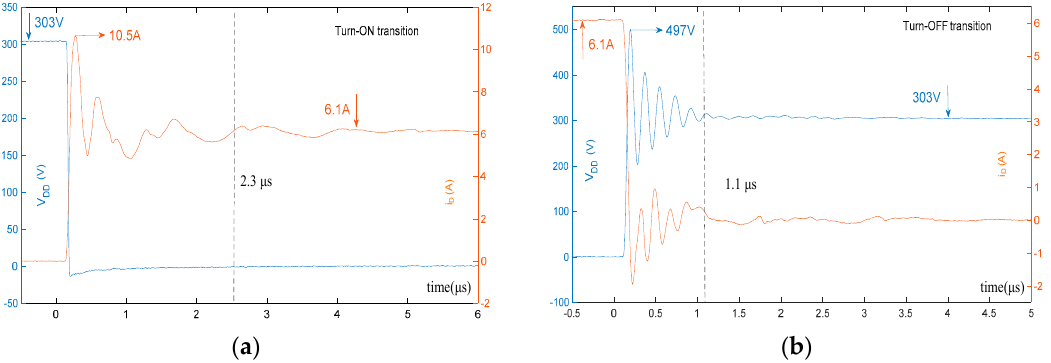
Figure 18. Switching transient under the condition of V in = 303 V, I L = 6.1 A, C X = 0.68 nF. ( a ) Turn-on transient without damping; ( b ) Turn-off transient without damping.